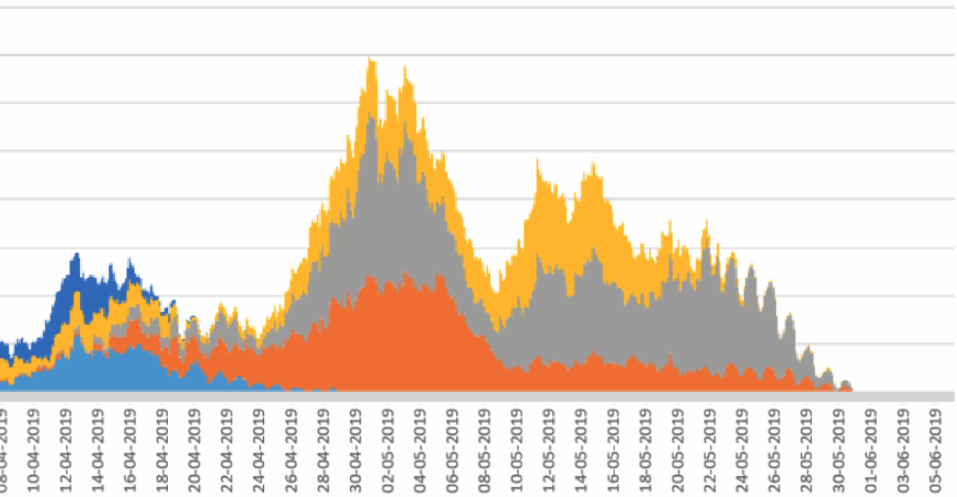
Figure 5. Stacked graph for aligned periodicity intensities for calves 1–5. Each colour represents a different